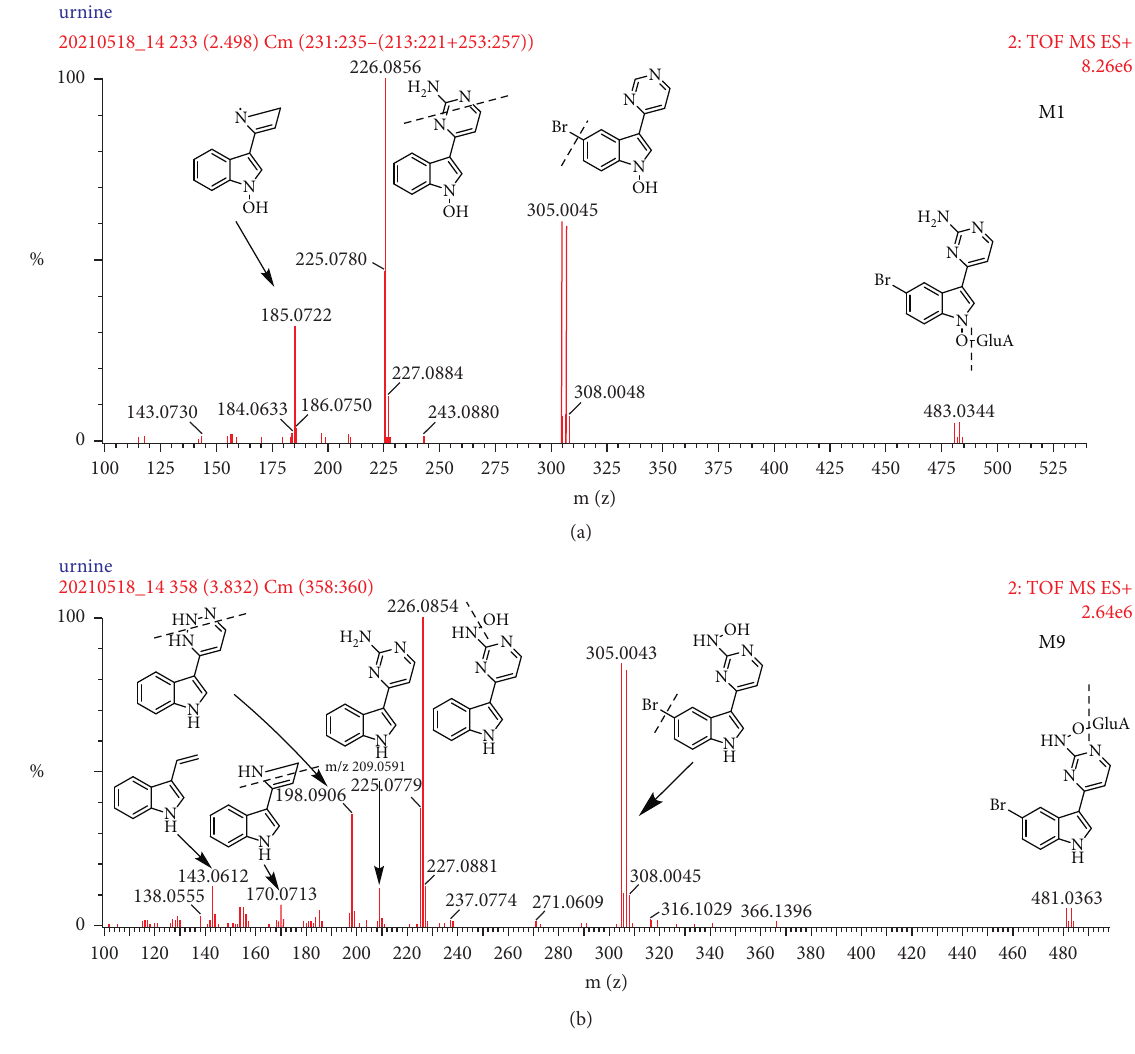
Figure 5: The product ion spectra and proposed fragmentation pathways of M1 and M9 in the positive ion